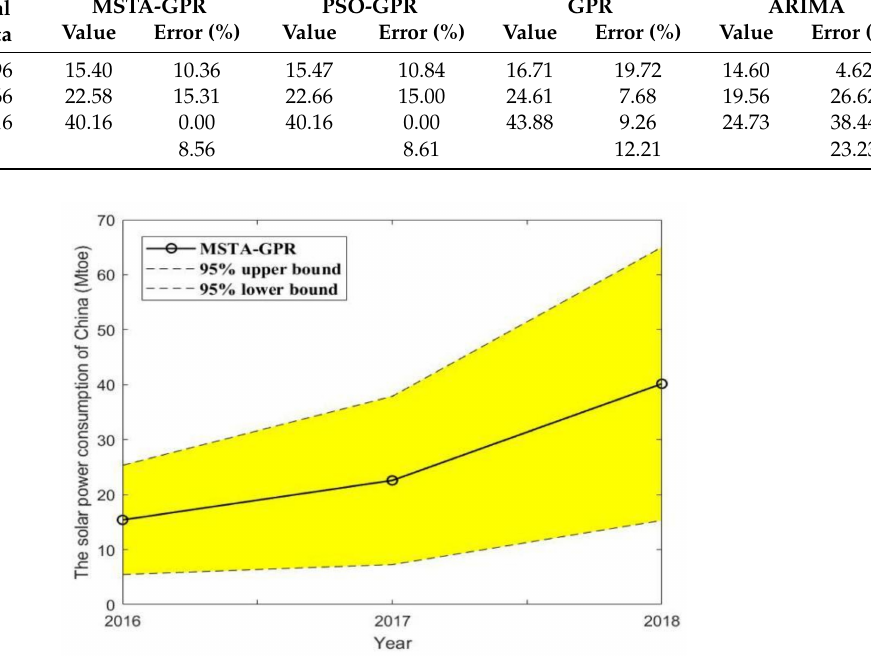
Figure A3. The interval prediction result of MSTA-GPR for China’s solar power